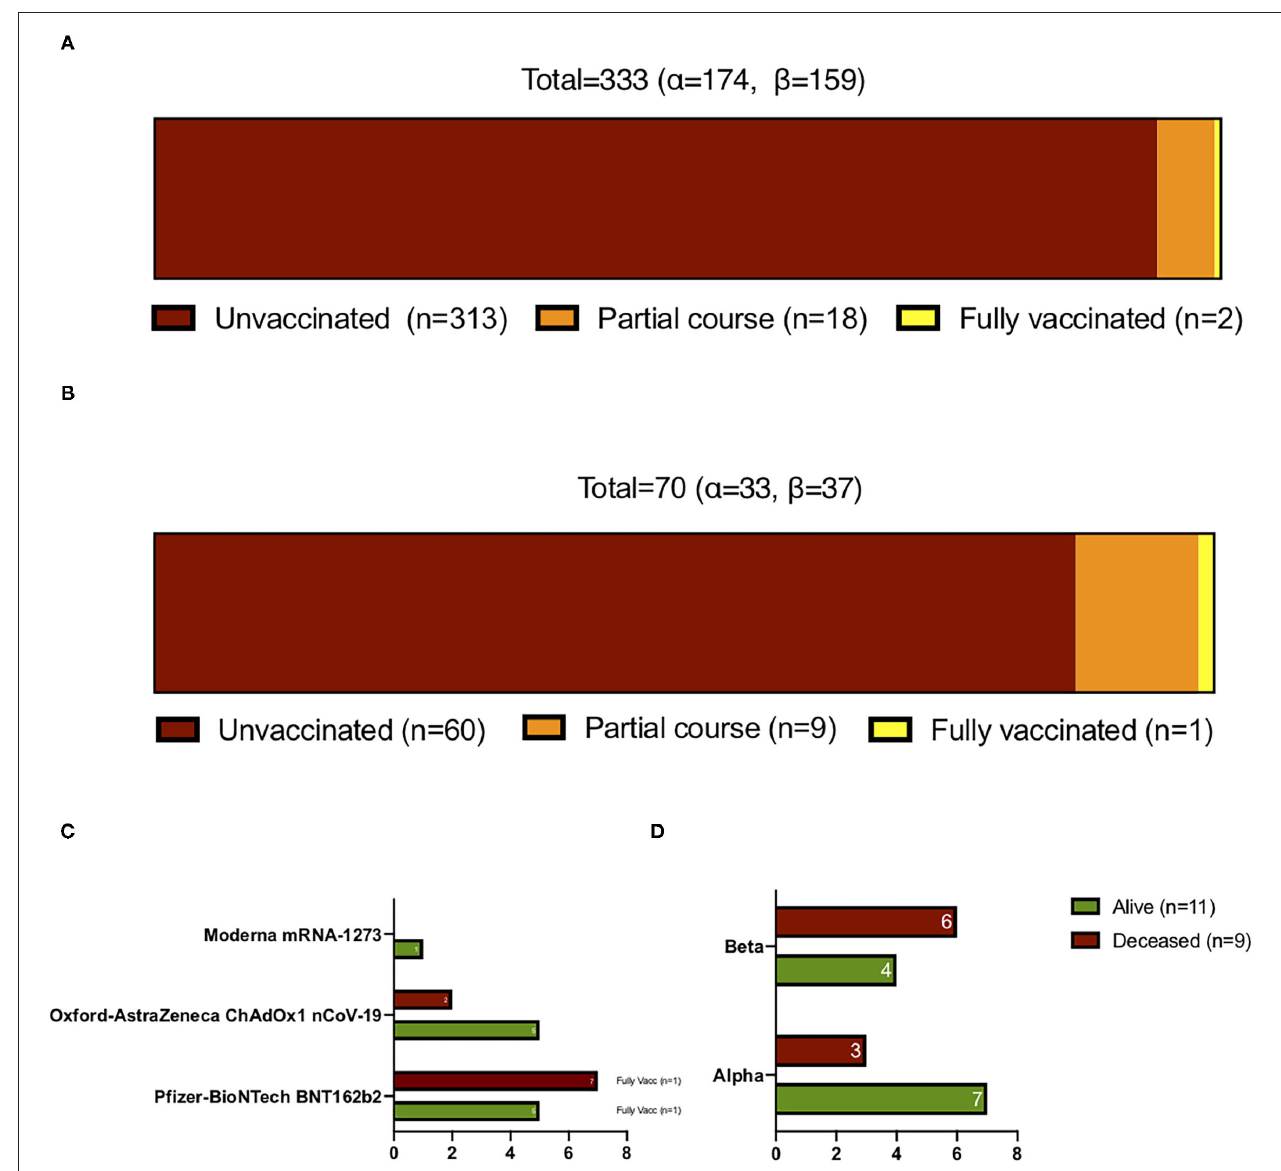
FIGURE 2 | Vaccination status of (A) the patients who were admitted to the ICU and (B,C) the patients who died by day 60. (B) Shows the overall vaccination status of the patients who died while (C) shows which vaccines they had received. (D) The variant in the vaccinated patients who died by day 60.